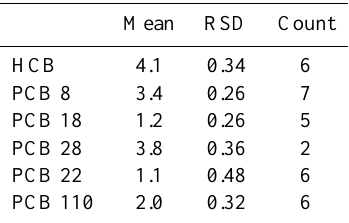
Table 3. PBT concentration (pgL − 1 ) in filtered Lake Superior wa- ter measured by Simcik et al. (2010) in July 2006. Mean, relative standard deviation (RSD), and number of measurements are re-